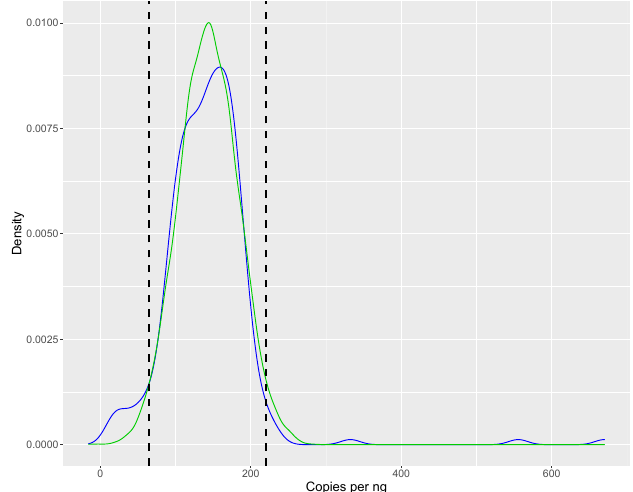
Figure 3. Density plot of the number of copies per ng template as measured by digital PCR in samples of high purity as confirmed by NGS. Dotted vertical lines indicate the boundaries between which 95% of the samples can be found. In green a normal approximation of the distribution is